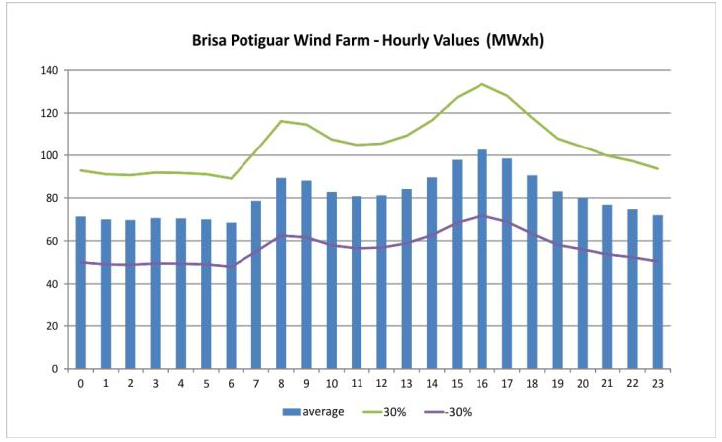
Figure 4. Brisa Potiguar wind farm daily behavior.